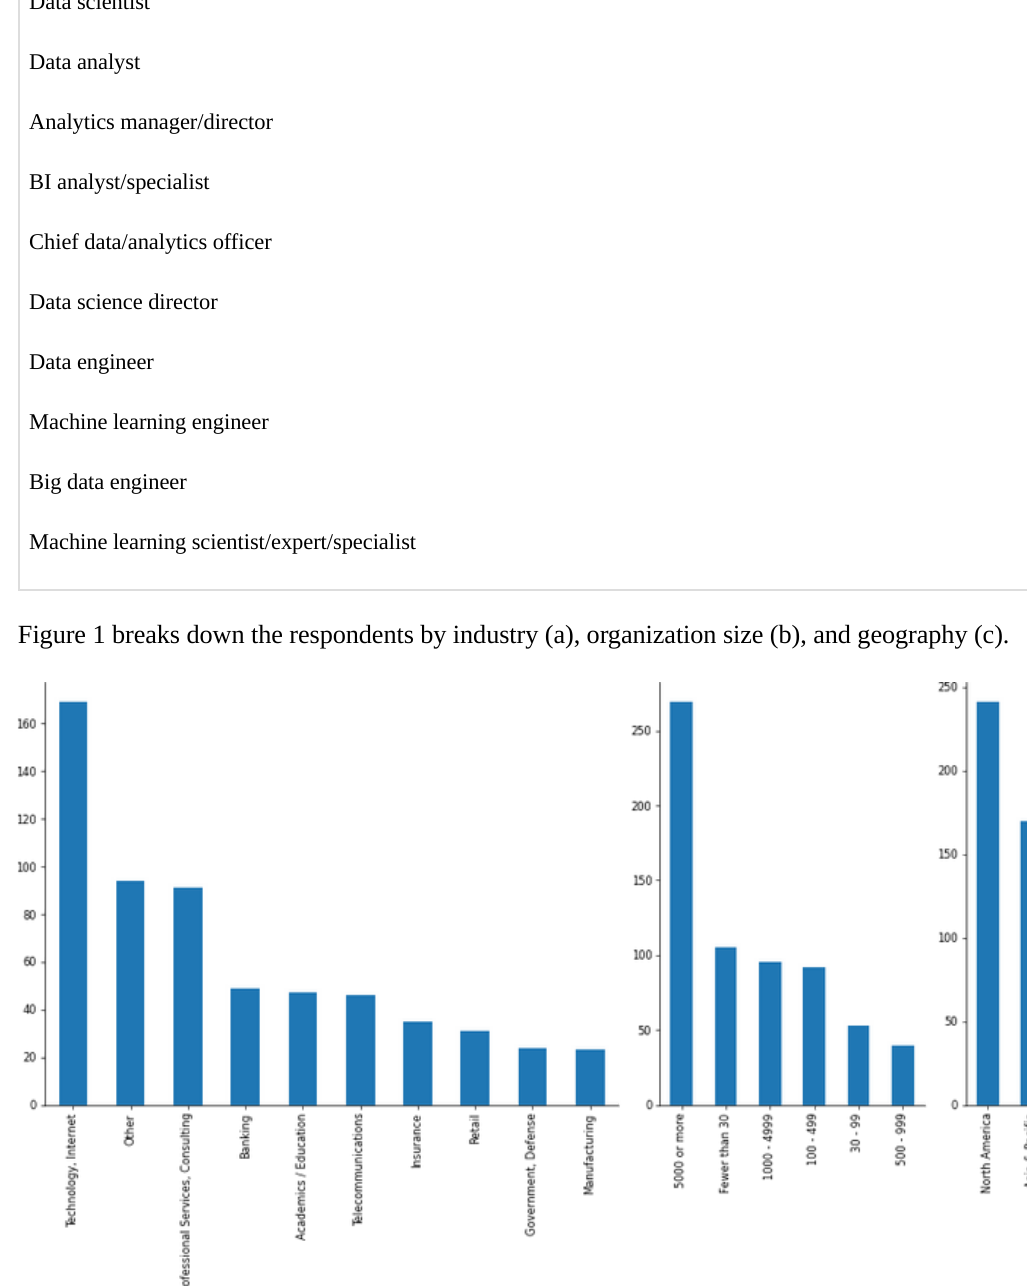
Figure 1. Number of respondents of the questionnaire by industry (left), by organization size (middle), and by geography